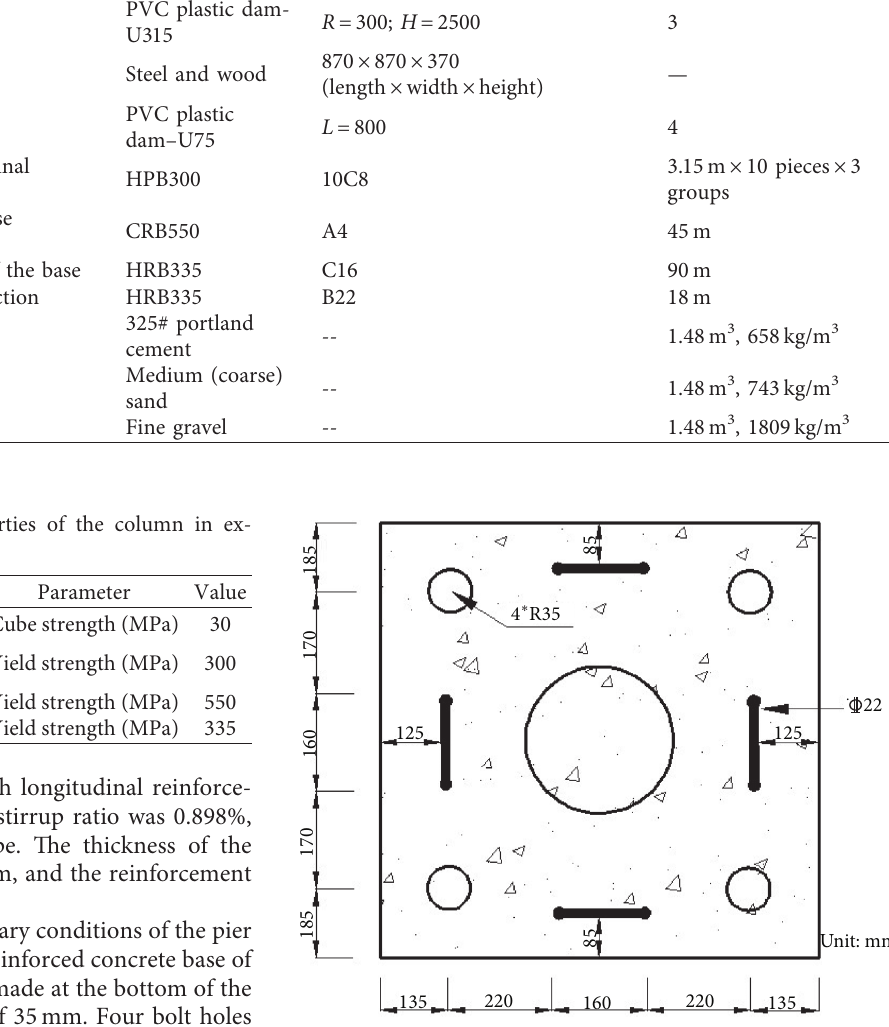
Figure 5: Size of reserved